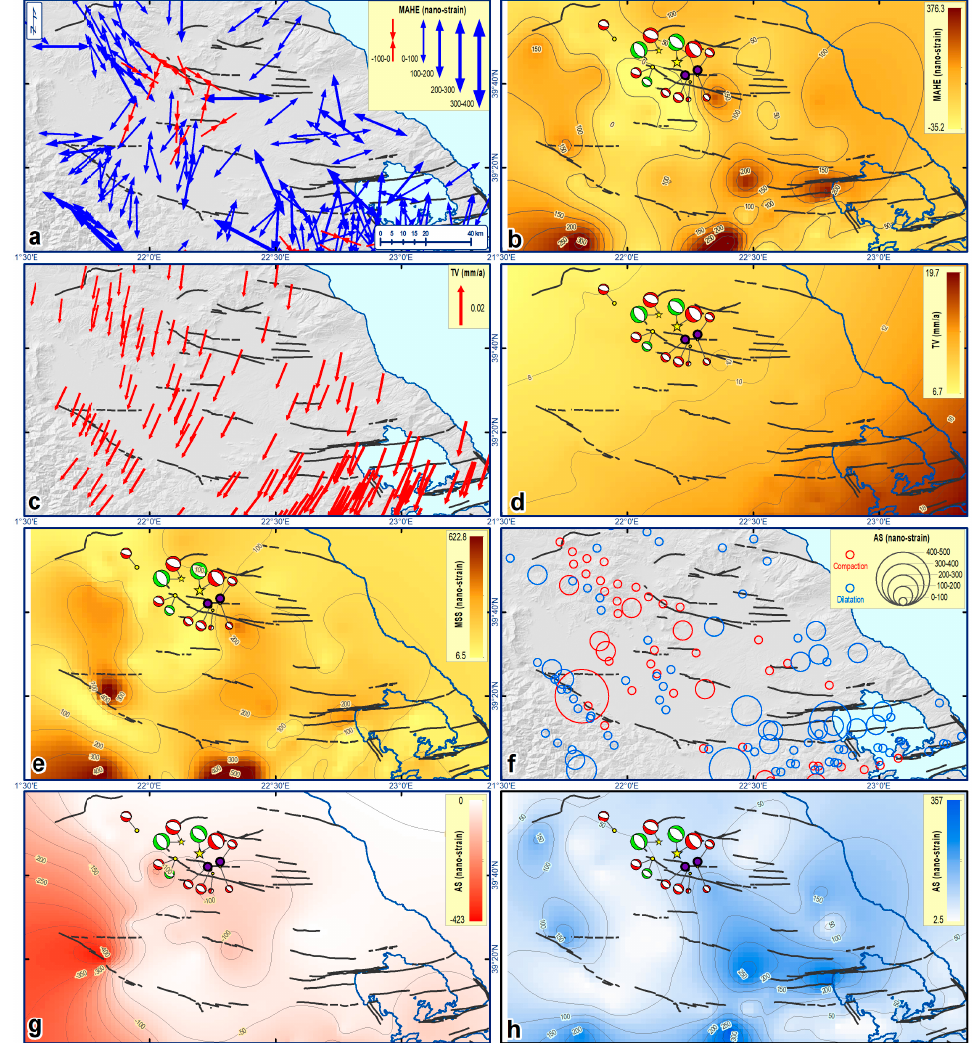
Figure 8. ( a ) Maximum Horizontal Extension (MAHE) as vectors and ( b ) interpolated. ( c ) Total Velocity (TV) as vectors and ( d ) interpolated. ( e ) Maximum Shear Strain (MSS) interpolated. ( f ) Area Strain (AS) as circles and ( g ) dilatation and ( h ) compaction interpolated. The major neotectonic/active faults and the moment tensor solutions [58,66] of the 2021 seismic sequence (Figure 7d) are also shown. After Lazos et al.